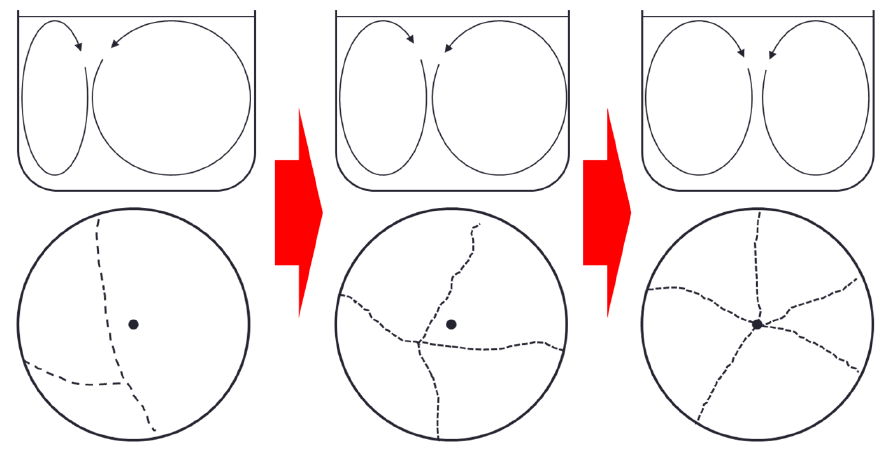
Figure 1. Spoke patterns on the surface of the melt according to temperature distribution in the crucible.